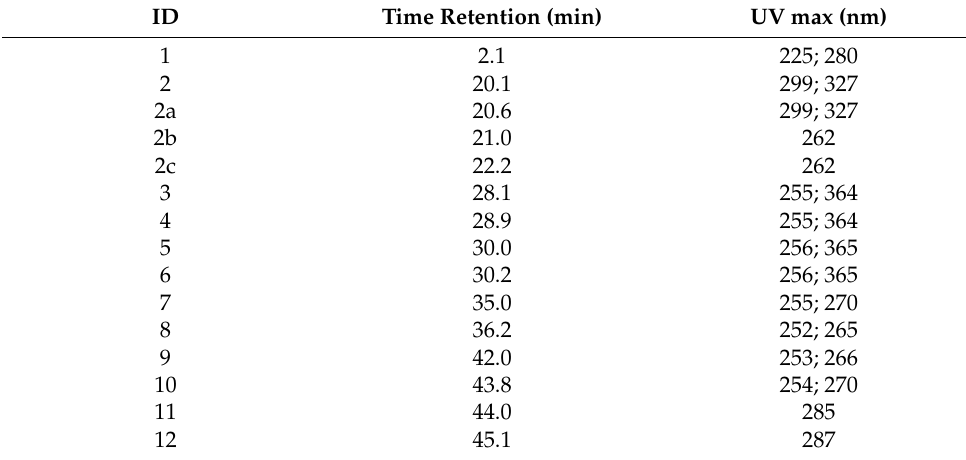
Table 1. UV-Vis data of the chromatographic peaks of the extract and fractions obtained from M. linifera